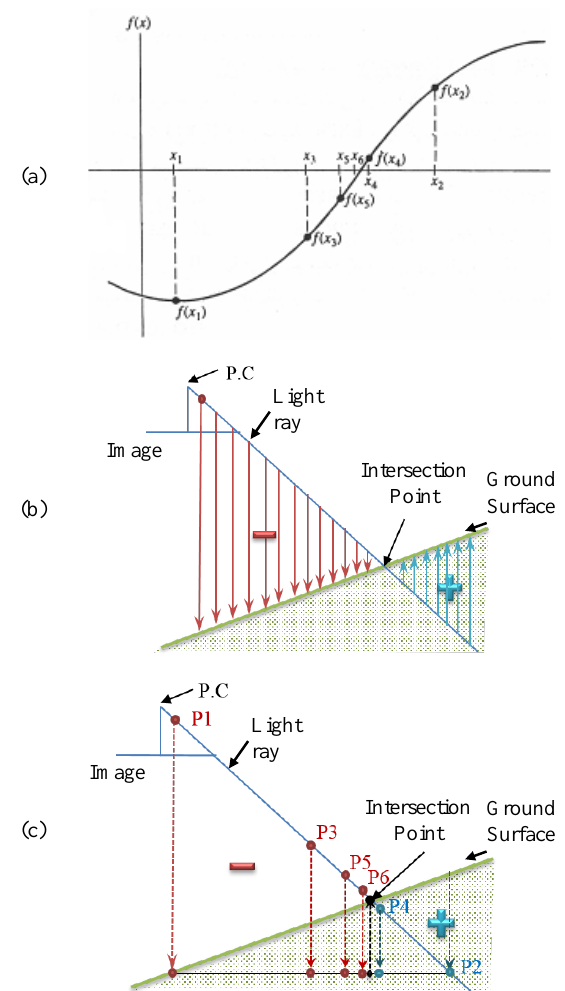
Figure 2. (a) Bisection method, (b) Bisection-based Ray-DSM intersection method, and (c) convergence process of the method